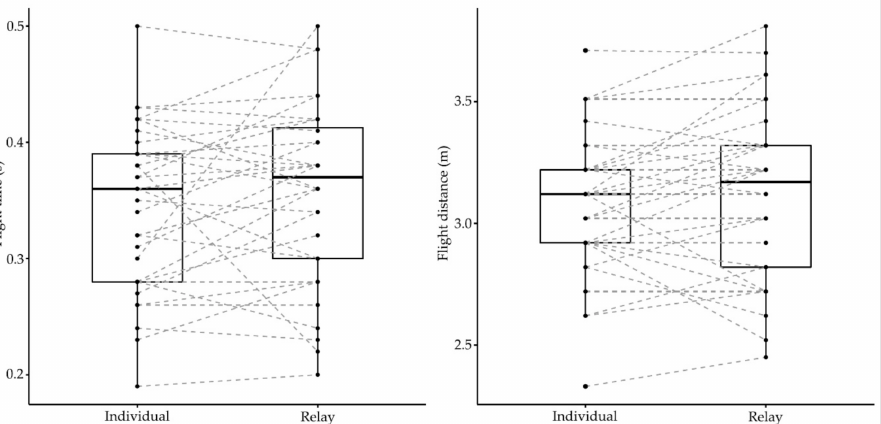
Figure 1. Individual and group variation in the flight start phase between individual and relay events of the LEN European Junior Swimming